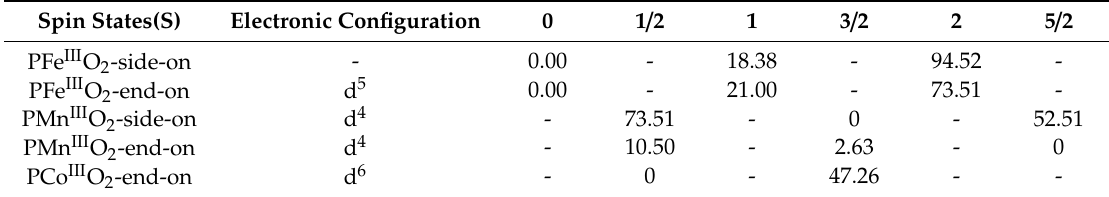
Table 2. Relative energies of the intermediates PM II O 2 (M = Fe, Mn, and Co).